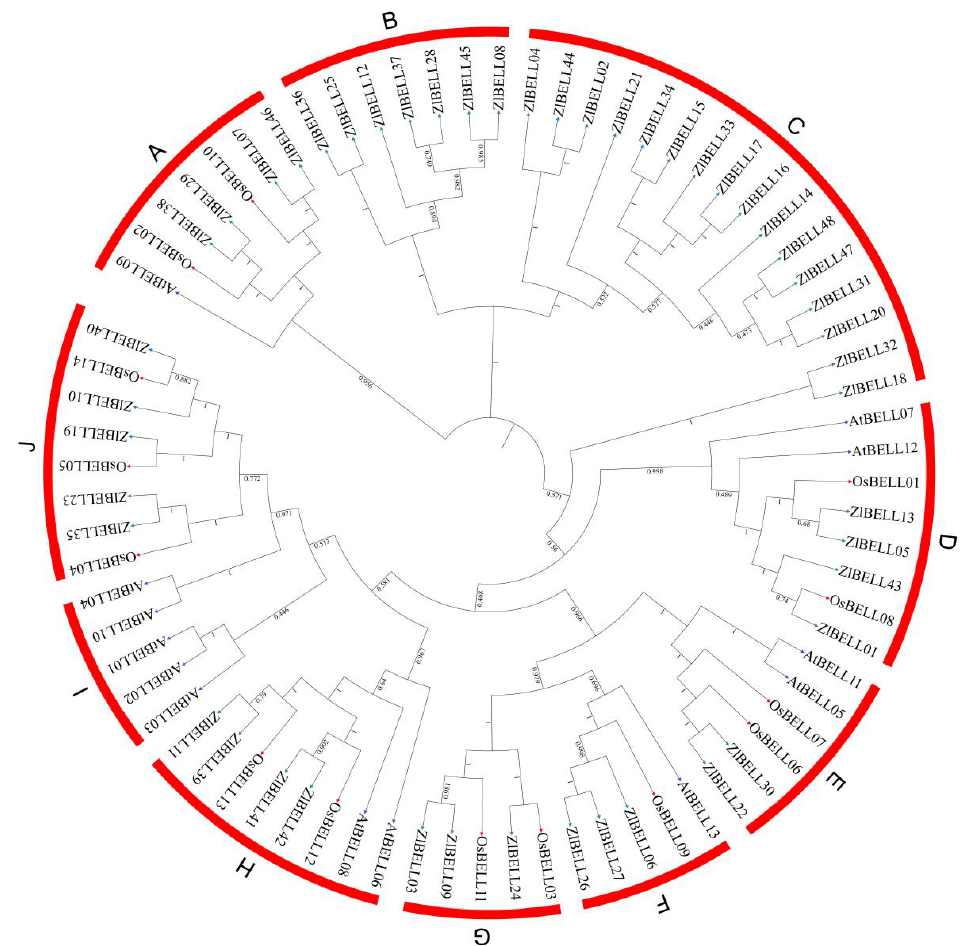
Figure 2. Phylogenetic analysis of BELL transcription factors in Arabidopsis thaliana (At), Zizania latifolia (Zl), and Oryza sativa (Os). The numbers on the major branches indicate bootstrap estimates for 1000 replicate analyses. ( A – J ) represent different subfamilies.